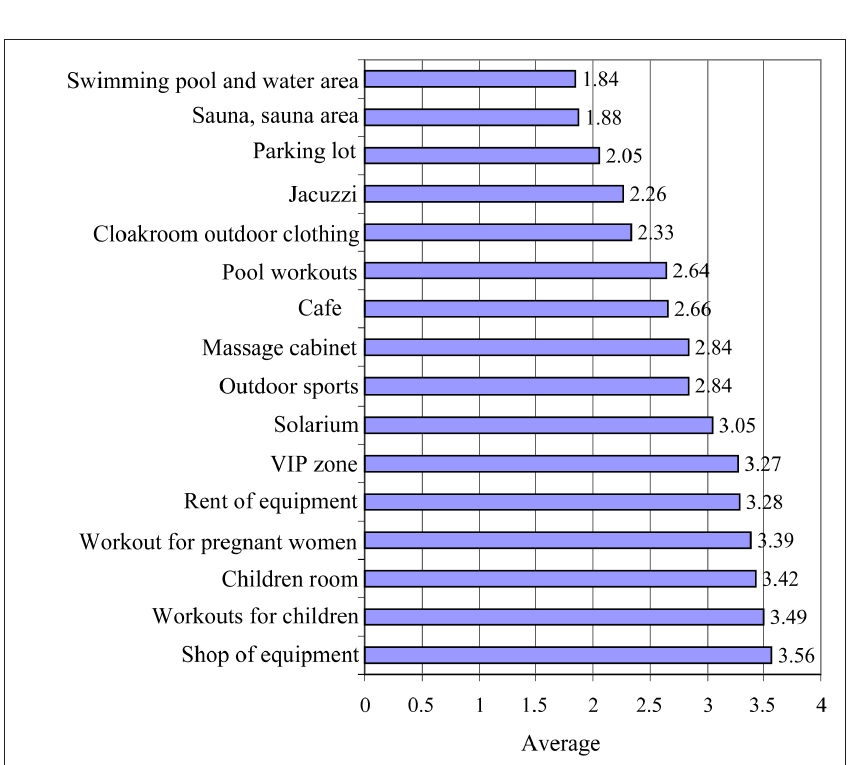
2. Significance assessment of the services provided by the